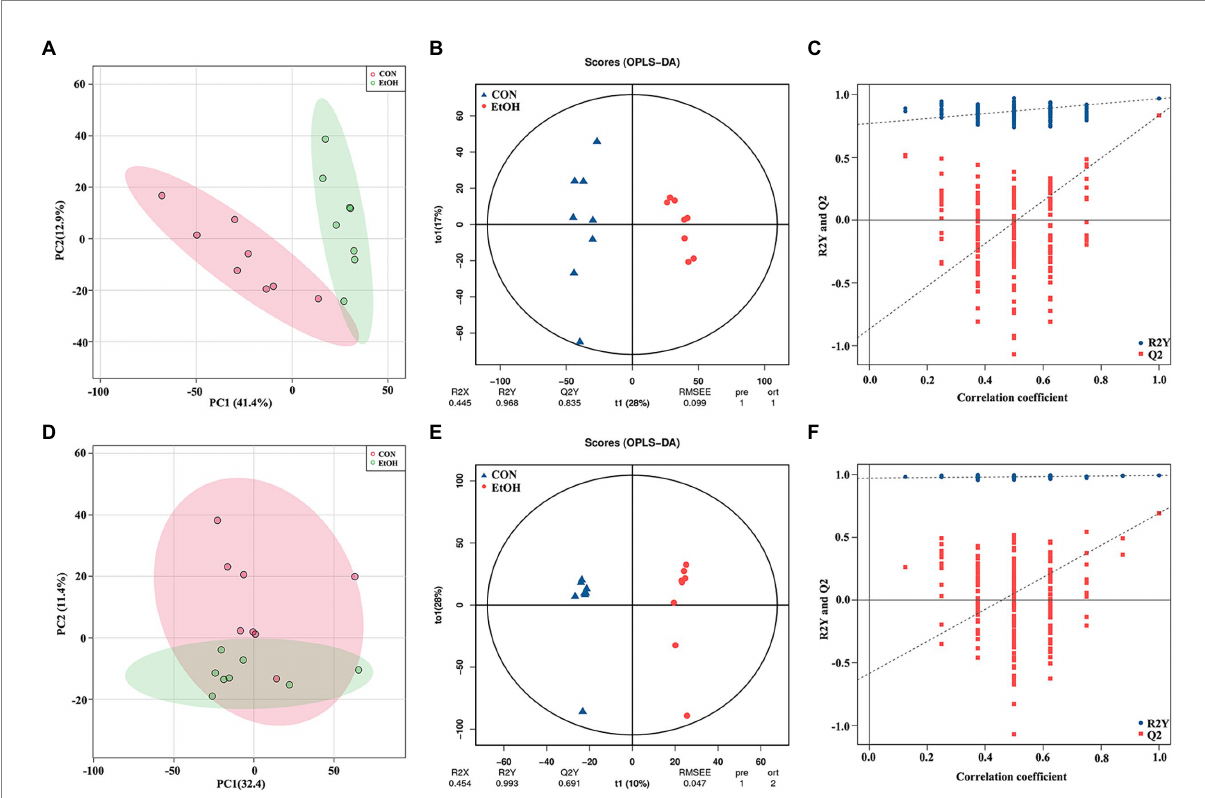
FIGURE 7 Multivariate statistical analysis of fecal metabolites measured by untargeted metabolomics analysis at positive (A–C) and negative (D–F) ion mode. PCA analyses comparing metabolites of all samples between EtOH and CON group (A,D) ; OPLS-DA scores showed significant differences between EtOH and CON group (B,E) ; and the OPLS-DA permutation test confirmed the differences of fecal metabolites in EtOH and CON group (C,F) .